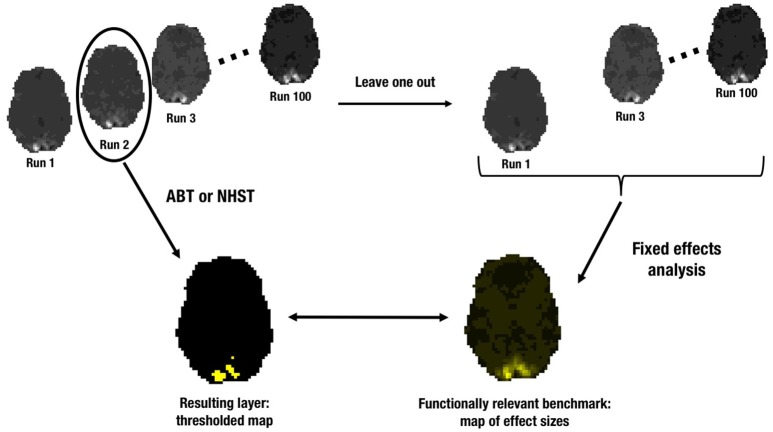
Illustration of the leave-one-out cross-validation procedure.